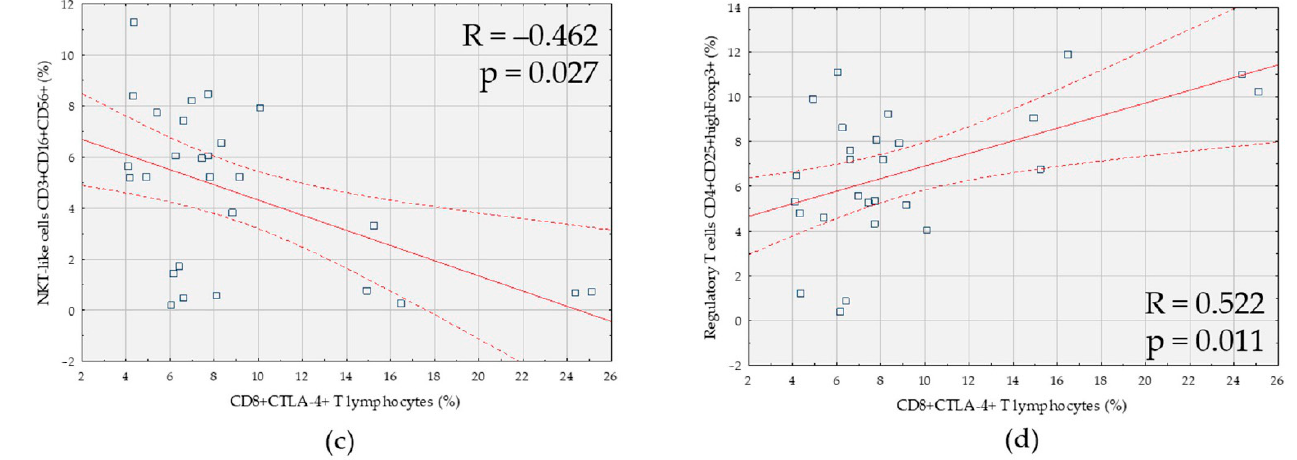
Figure 3. Correlation between the percentage of CD8+ T cells expressing CTLA-4 (CD8+CTLA-4+) and: ( a ) the number of monocytes; ( b ) the percentage of NK cells (CD3-CD16+CD56+); ( c ) the percentage of NKT-like (CD3+CD16+CD56+) cells; ( d ) the percentage of subpopulation of regulatory T cells with high forkhead box P3 expression (CD4+CD25+highFoxp3+) in patients with endometriosis and coexisting infertility ( n = 27).